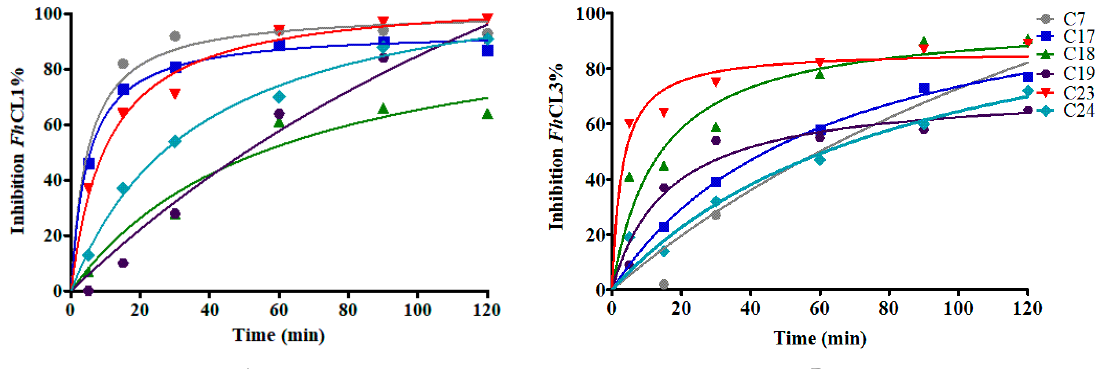
Figure 5. The effect of increasing the preincubation time of the compounds (at 10 µM) with the enzymes on the inhibition percentage to test for slow-binding kinetics. The enzymatic activity for (A) Fh CL1 and (B) Fh CL3 was measured after incubation of each enzyme with the inhibitors for different lengths of time from 5 to 120 min.